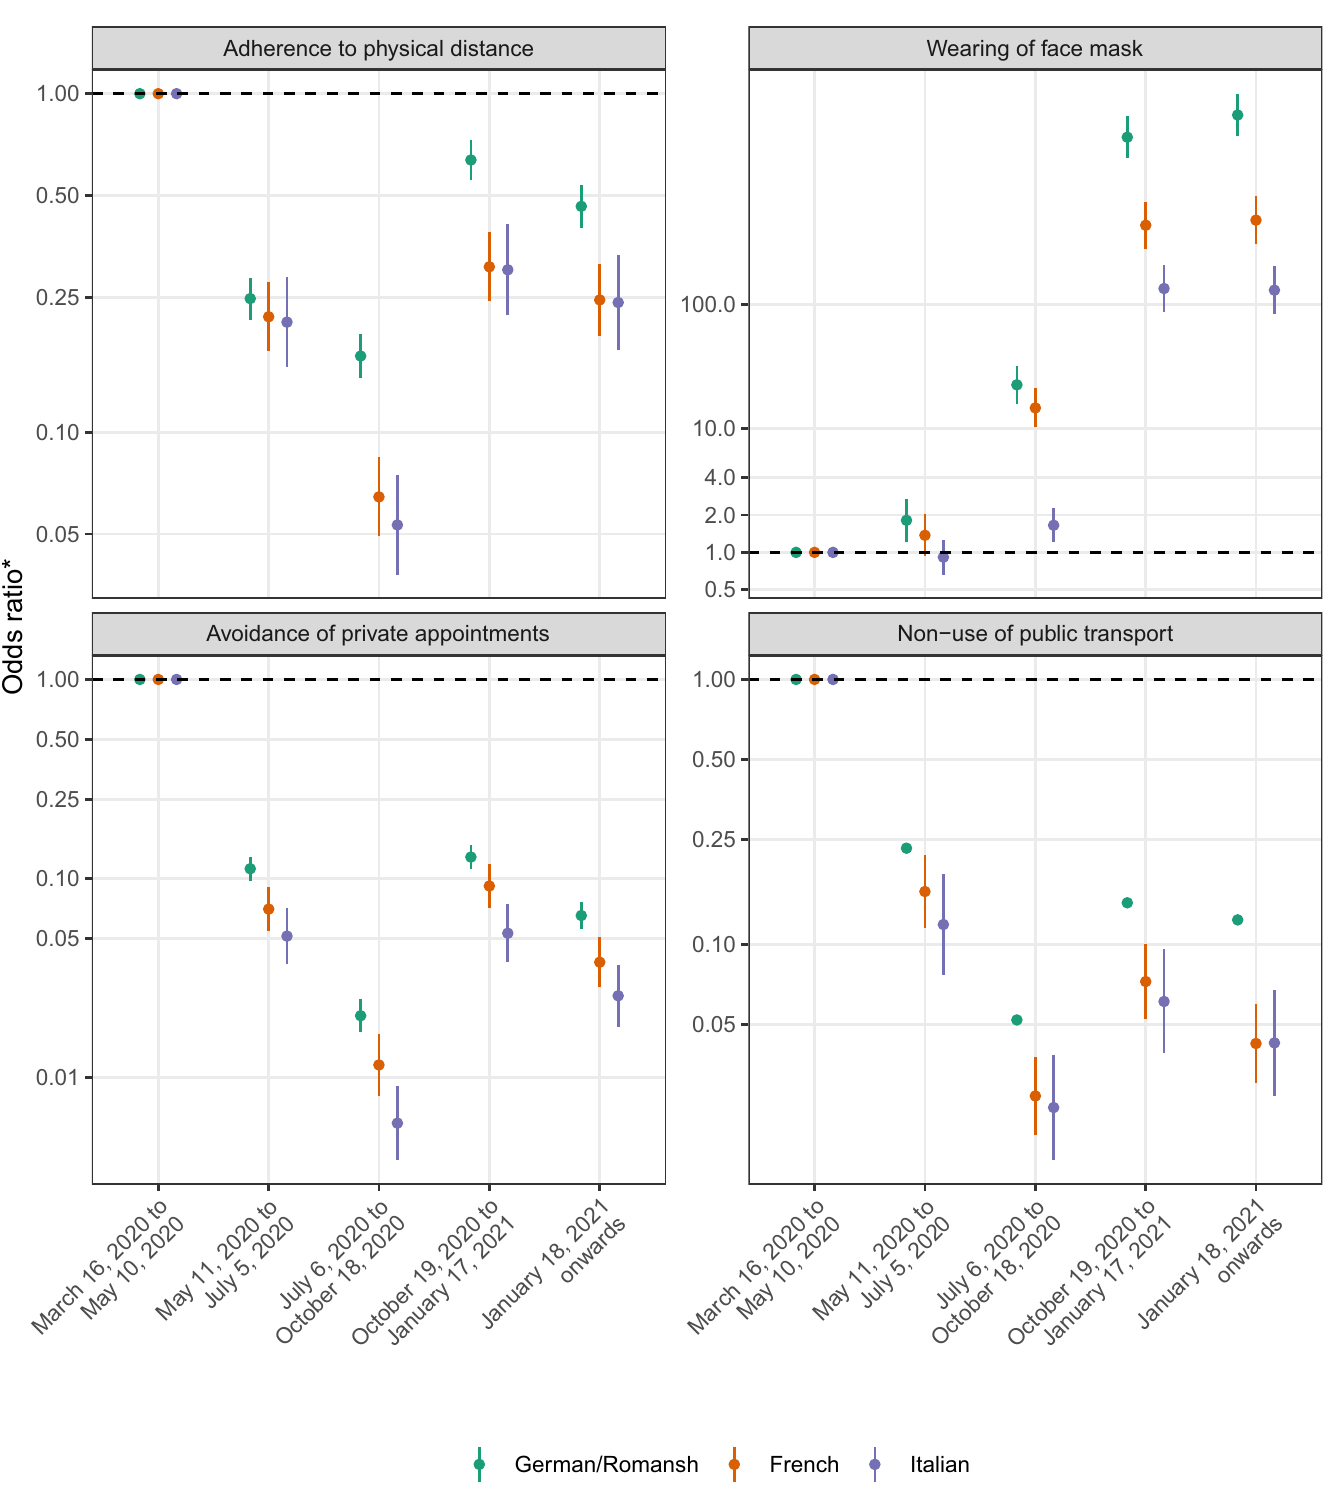
Fig 8. Results from adjusted hierarchical logistic regression models for the study outcome domain of adherence to mitigation measures, by mitigation period, language region and for whole Switzerland.